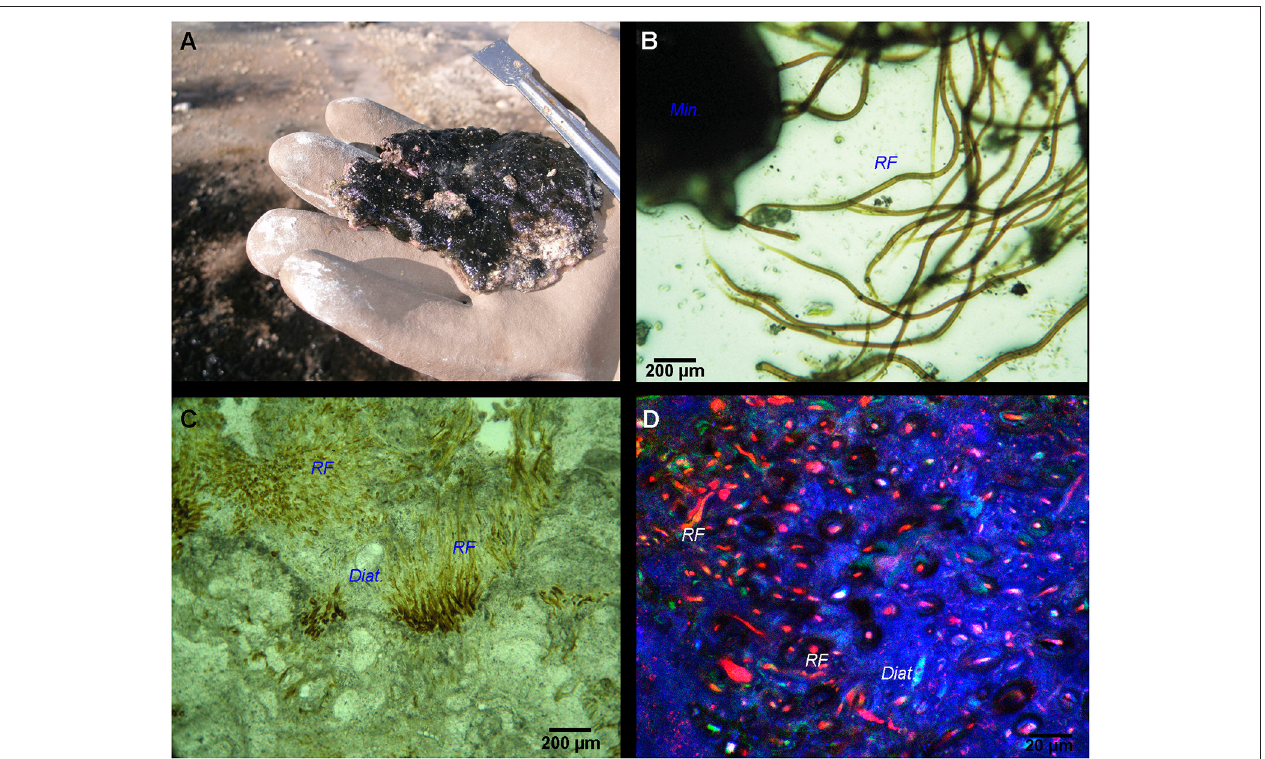
FIGURE 2 | (A) Black pustular mat with visible white-colored carbonate precipitates. (B) Optical microscopy image of the BP mat highlighting Rivularia filaments ( RF ) associated with minerals ( Min. ). (C) Paintbrush-like palisade fabric of Rivularia -like filaments encrusted by carbonates and preserved inside an oncoid lamination alternating with other lamination types (like sparry, botryoidal and micritic). Encrusted diatoms ( Diat. ) can also be found. (D) CLSM image of the same lamination enclosing Rivularia -like filaments whose remaining pigments show red fluorescence. The mineralized portion of the oncoid appears in blue due to laser reflection on solid